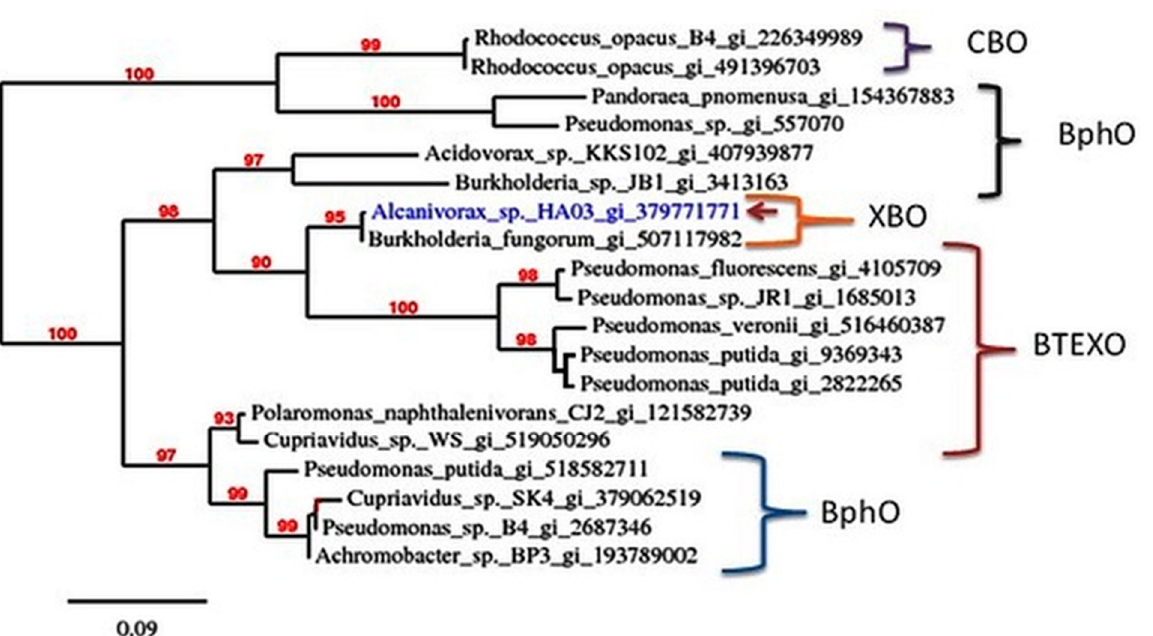
Figure 2. Phylogenetic showing the relatedness of the Alpha subunits of Rieske non-heme iron oxygenases of Alcanivorax sp. HAO3 with the other nearest Alpha subunits. The phylogenetic tree was generated using Phylogeny.fr based on protein sequence alignment. CBO (chlorobenzene dioxygenase); BphO (Biphenyl dioxygenase); XBO (halobenzene dioxygenase); BTEXO (Benzene, Toluene, Ethylbenzene and xylene dioxygenase).